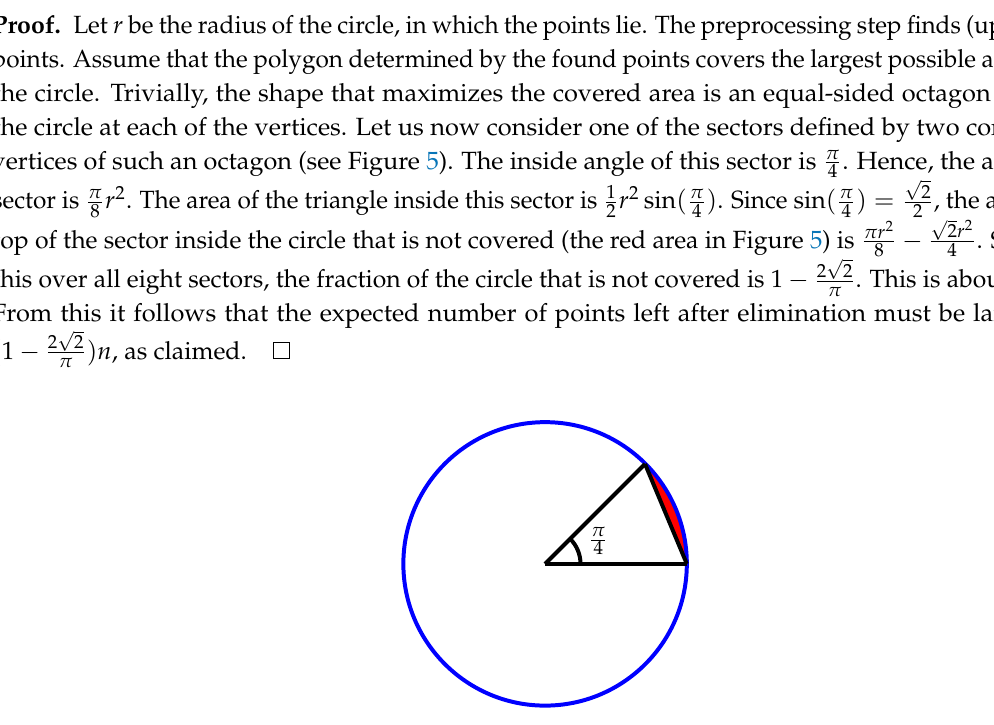
Figure 5. The region uncovered by THROW - AWAY preprocessing for the disc data